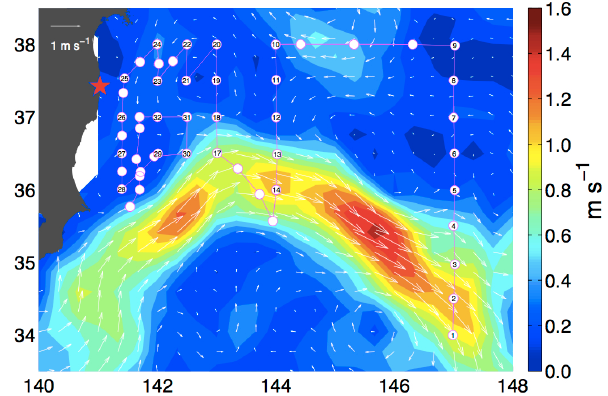
Fig. 1. Sampling stations, with their corresponding station numbers (see Table 1 for more details), superimposed on surface velocities (from Buesseler et al., 2012). Grey contour on the left represents the Japan coast, whereas the red star stands for the Fukushima Dai-ichi